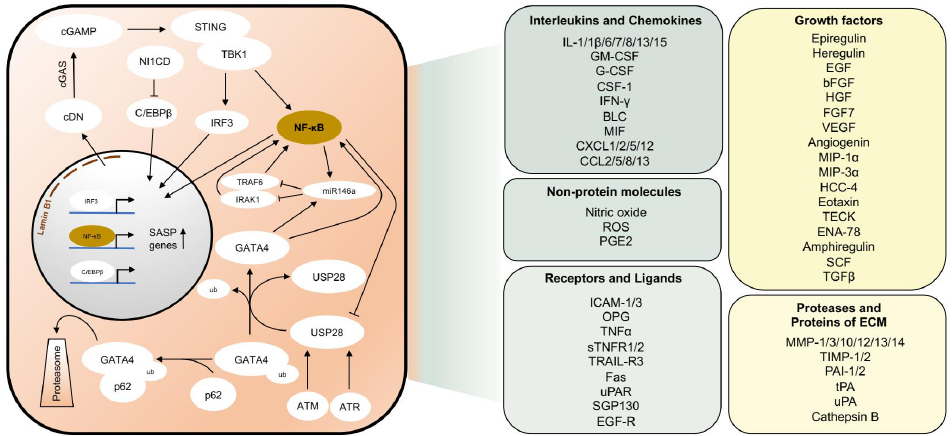
Figure 2. Pathways responsible for the induction of the senescence-associated secretory phenotype (SASP). Schematic representation of major pathways that are activated in senescent cells leading to the expression of SASP genes (left panel). Most important SASP factors according to [68 – 70] (right panel). cDN, cyclic dinucleotides. ECM, Extracellular matrix. ub, Ubiquitin. 3. Treatment Strategies for Myeloid Malignancies that Involve Cellular Senescence Myeloid malignancies are clonal disorders of the hematopoietic stem or progenitor cells that are caused by genetic mutations or epigenetic alterations. These mutations lead to changes in proliferation, differentiation, or self-renewal. Myeloid malignancies include chronic stages, such as myelodysplastic syndromes (MDS), myeloproliferative neoplasms (MPN), and acute stages, such as acute myeloid leukemia (AML). Recently, preclinical studies and early clinical trials have highlighted several molecular targets that are effec- tive in the treatment of myeloid malignancies either by additional senescence induction or by eradication of senescent cells (Table 1).